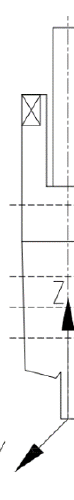
Figure 3. The Mesh. Figure 3. The Mesh . Figure 3. The Mesh .